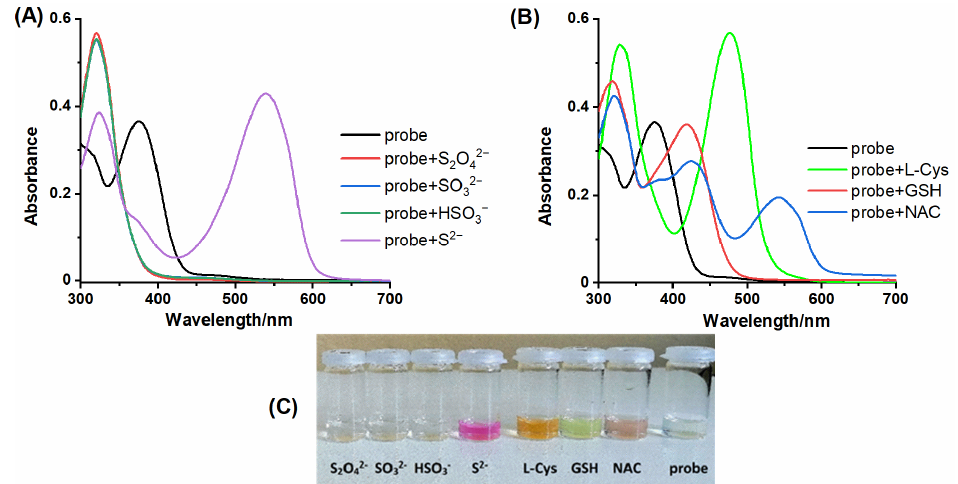
Figure 3. The UV-vis absorption spectra of probe NBD-O-CmCH 2 OH (7.5 μ M) upon the addition of 5 equivalents of various ( A ) sulfur species and ( B ) biothiols in MeCN-PB (1:9 v/v , pH 7.4). ( C ) Photograph of the probe in the presence of different analytes.